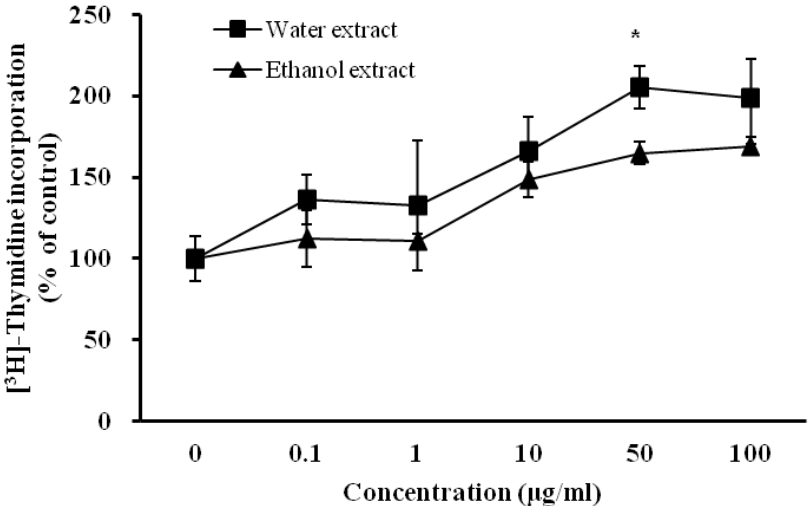
Figure 4. Effects of water and ethanol extracts from Drynariae rhizoma on DNA synthesis of mouse osteoblastic cells. Cells were treated with vehicle or various concentrations of D. rhizoma extracts for 48 h. Results are expressed as percentage of control (vehicle). Significant differences were compared with vehicle control ( p <